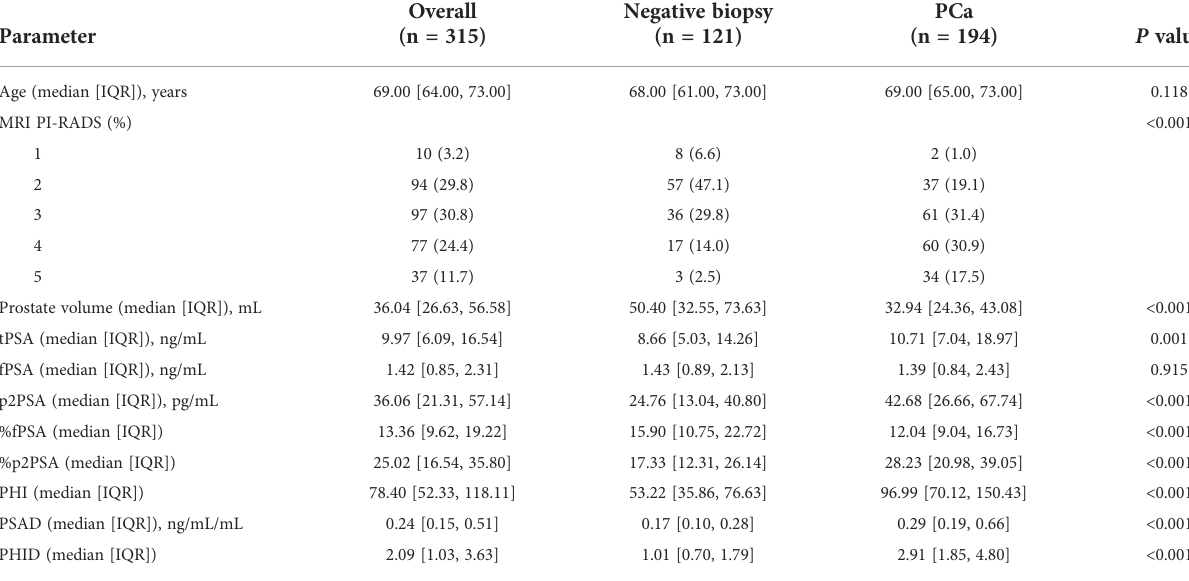
TABLE 1 Demographic and clinical characteristics of the study